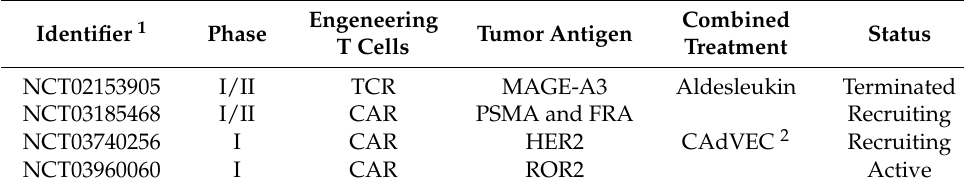
Table 2. Ongoing T cell therapy clinical trials in bladder